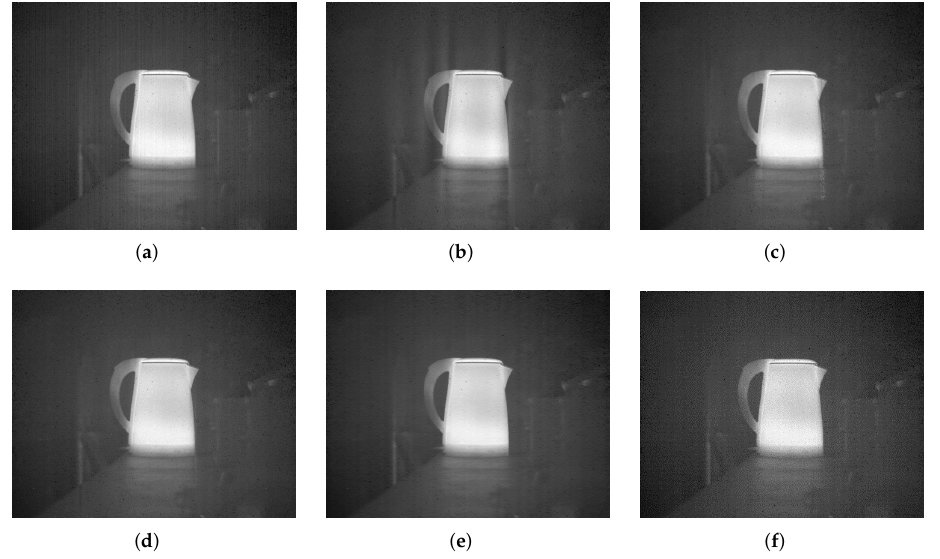
Figure 9. Stripe nonuniformity correction results for Kettle. ( a ) Raw; ( b ) WTSF; ( c ) MIRE; ( d ) GIF; ( e ) CNN; ( f ) Ours.